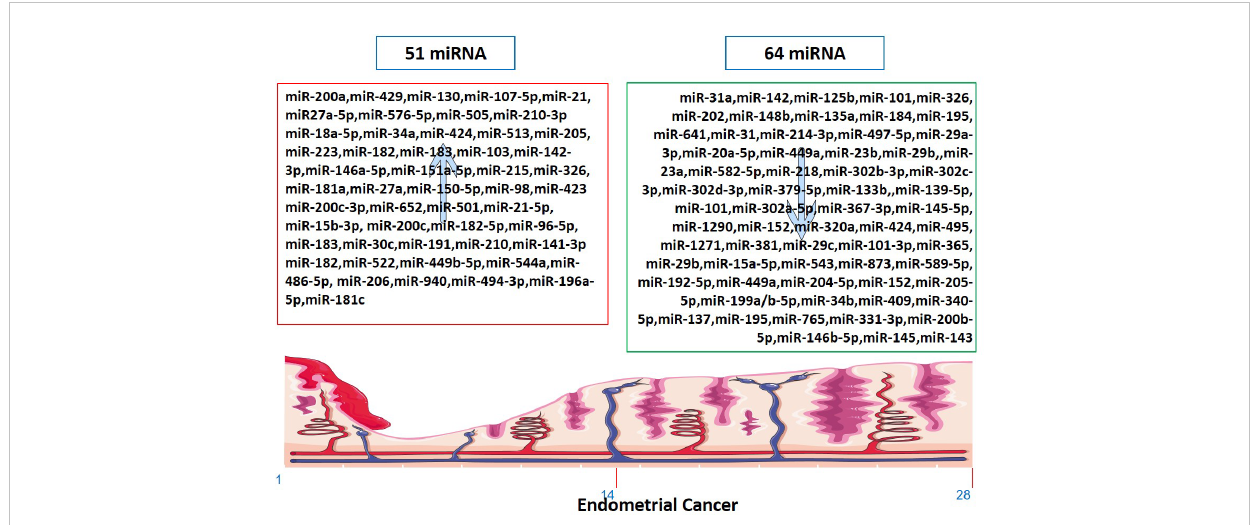
FIGURE 2 Up-regulated and down-regulated miRNAs in Endometrial Cancer. The markings 1, 14 and 28 in the bottom of endometrium, depicts the days of menstrual